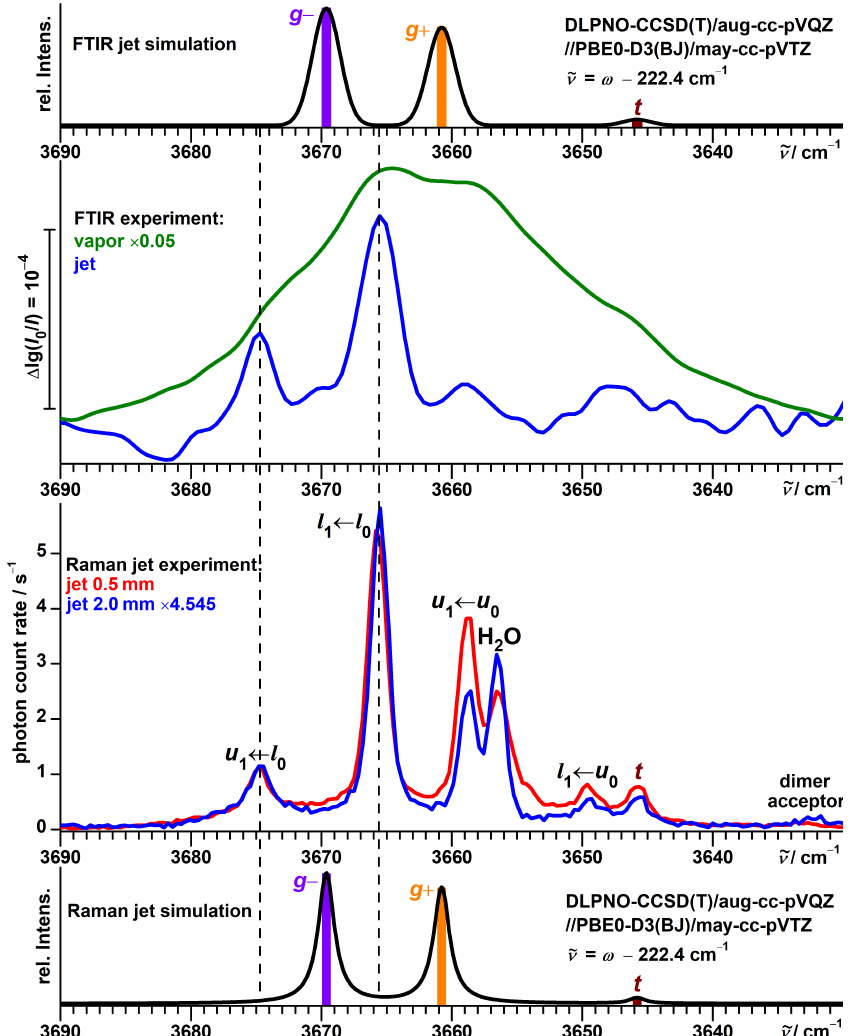
Figure 3. Top half: Comparison between simulated and experimental FTIR jet spectra of α -fenchol. In addition, an FTIR spectrum of the vapor at ambient temperature is shown. Bottom half: Comparison between simulated and experimental Raman jet spectra of α -fenchol at two different detection distances from the nozzle. For the simulations, a Boltzmann distribution of localized conformers is assumed at a conformational temperature of 100 K. Harmonic OH stretching wavenumbers are uniformly shifted according to the model of Ref.